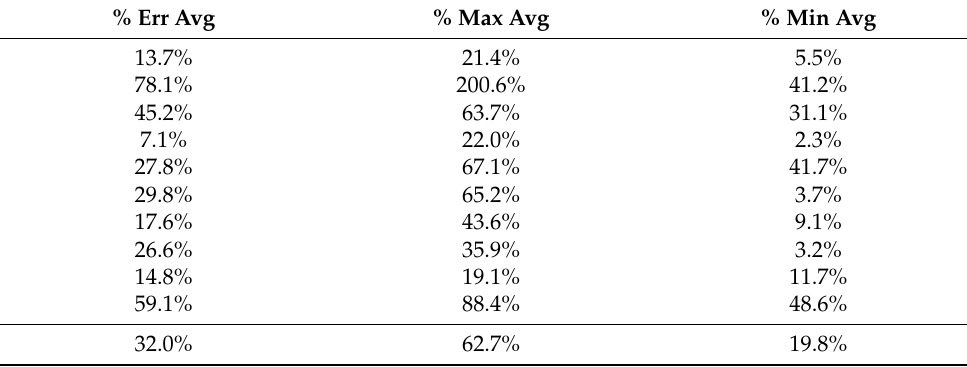
Table A10. Set 1, trials 1–10 data (actual PR value).